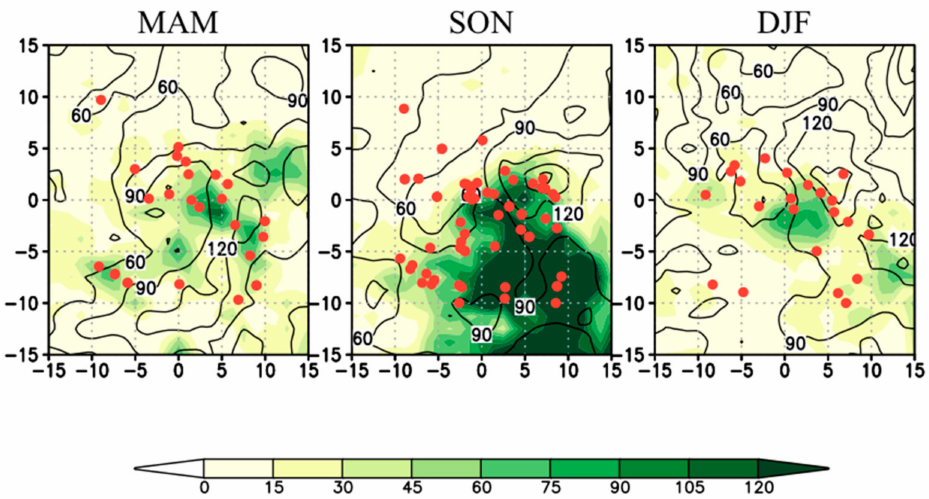
Figure 4. Cyclone relative composite: convective available potential energy ( CAPE ) (colors; J kg − 1 ), SREH (lines; m 2 s − 2 ) in ( left ) spring, ( middle ) autumn, and ( right ) winter. Cyclone-relative tornado locations are shown with red